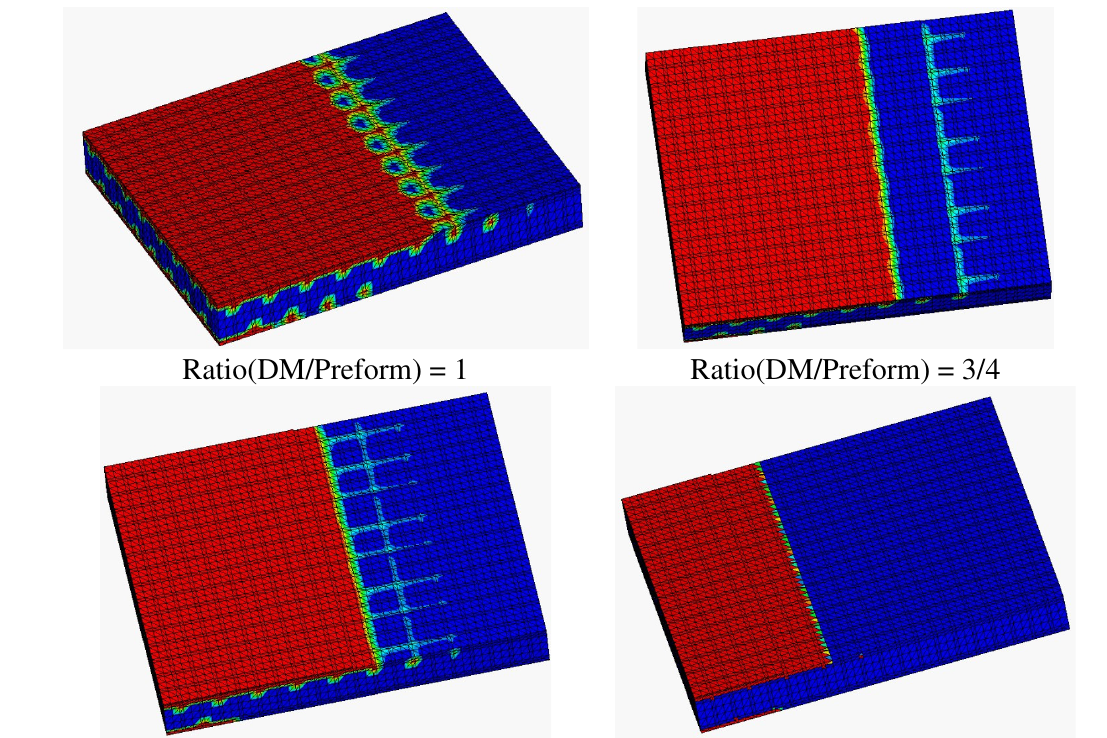
Figure 2. Sketch map of resin flow front at 90 s (distribution medium